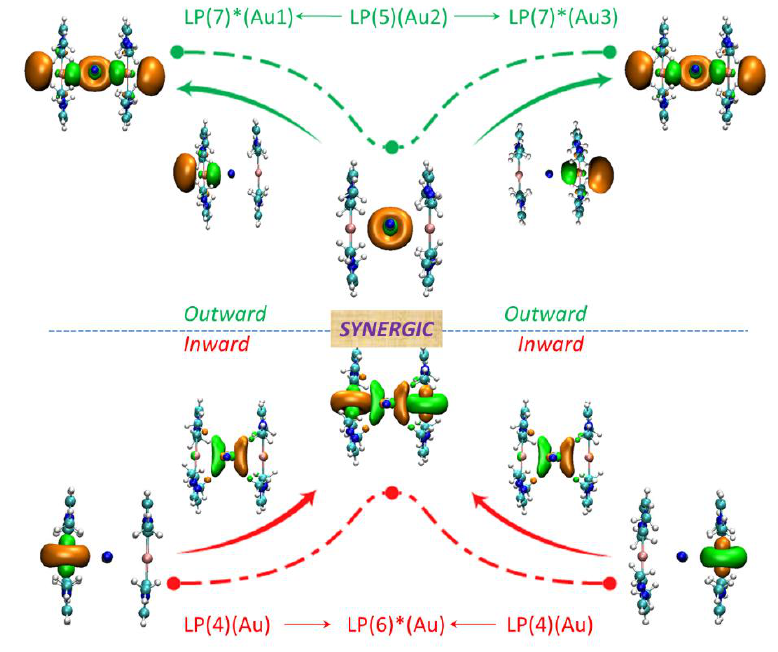
Figure 2. The orbital interaction of aurophilic interaction (outward and inward) in cluster I .